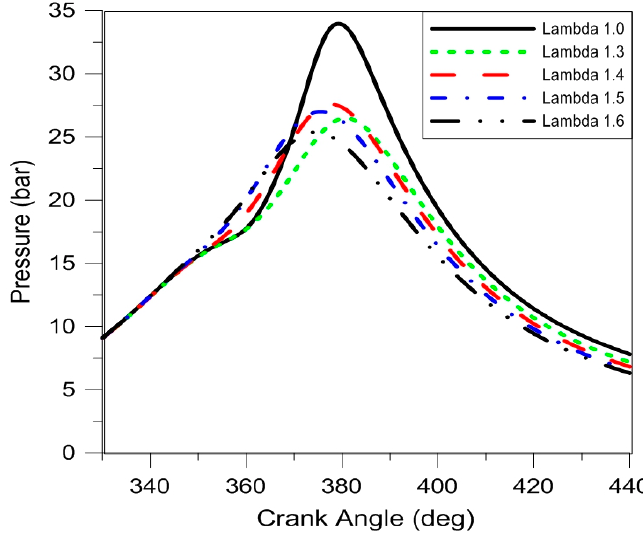
Figure 6. In-cylinder pressure traces averaged over 200 consecutive cycles for each tested air–fuel ratio.